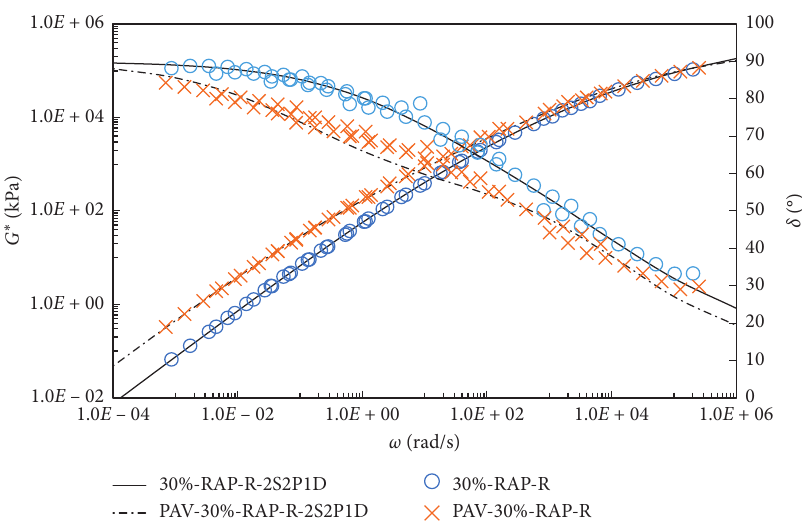
Figure 11: Complex shear modulus and phase angles master curves for RAP-R binder containing 30% RAP binder before and after PAV aging.